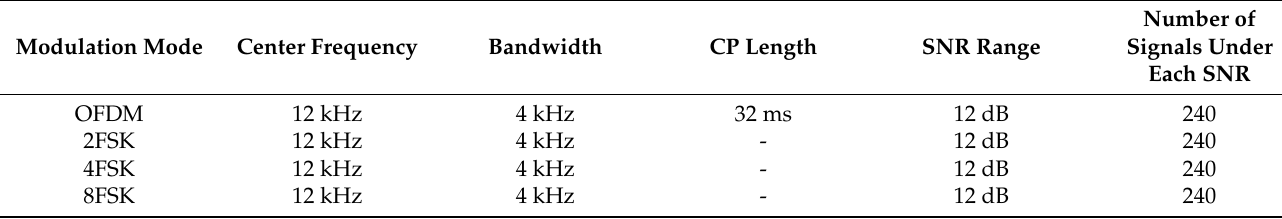
Table 3. Parameter setting of the experimental